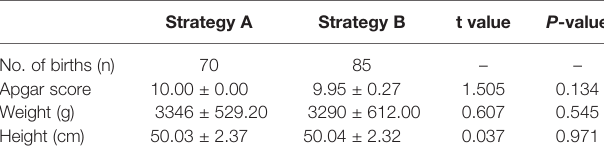
TABLE 4 | Health of